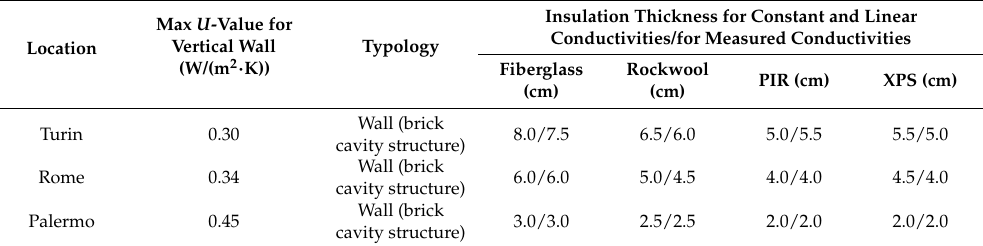
Table 1. Maximum U -value data prescribed in Italy used for the selection of the building systems and insulation thickness for constant, linear, and measured conductivities—external walls.